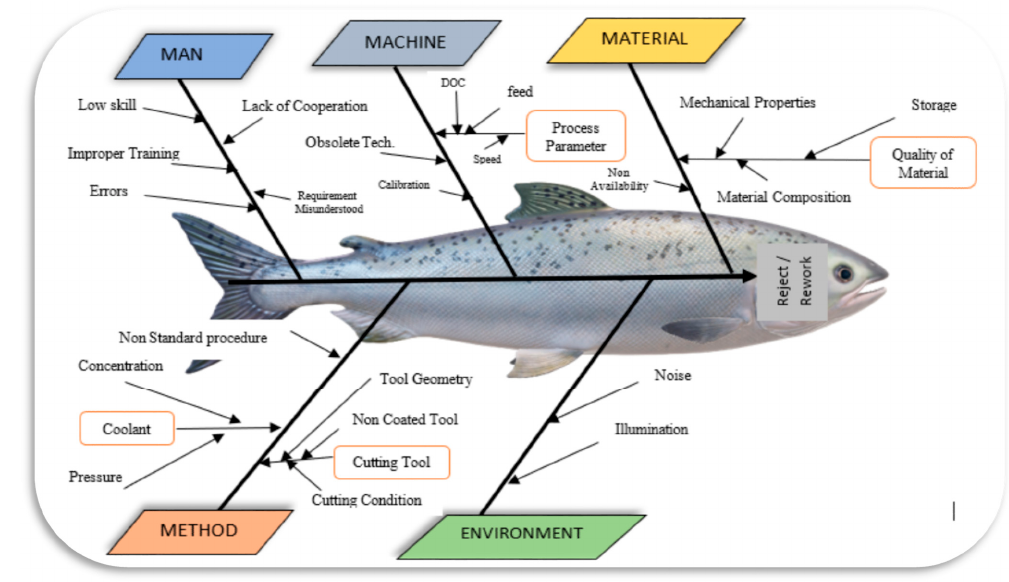
Figure 5. Fishbone diagram for rework/reject.